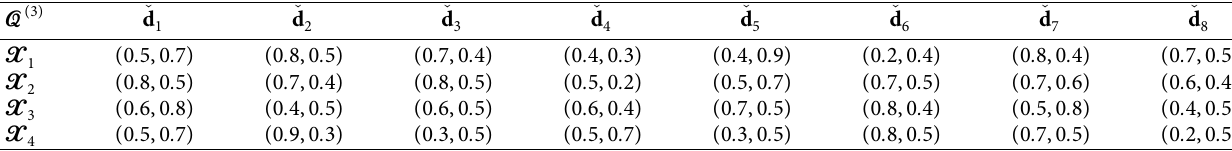
Table 3: Decision matrix for alternative Q ( 3 ) .